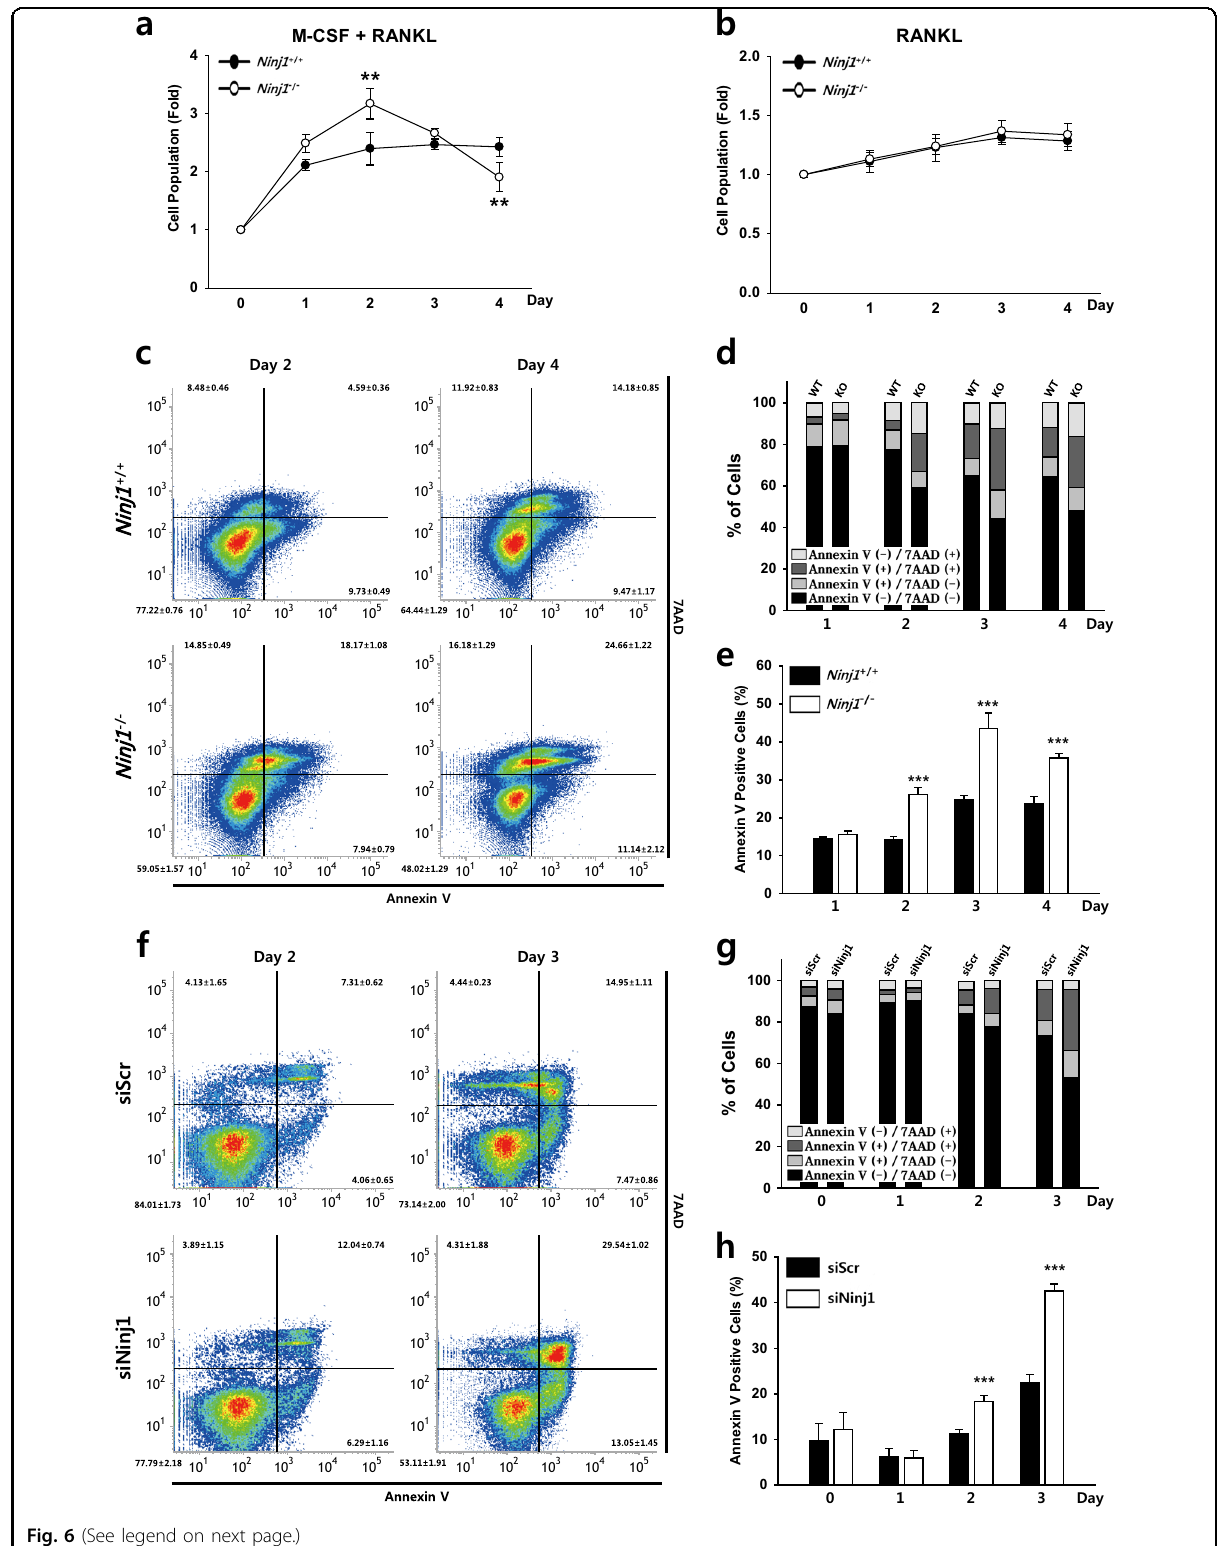
Fig. 6 (See legend on next